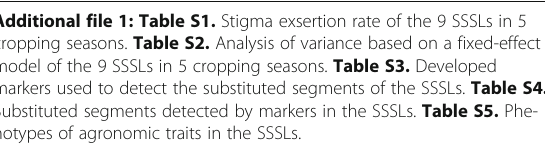
Additional file 1: Table S1. Stigma exsertion rate of the 9 SSSLs in 5 cropping seasons. Table S2. Analysis of variance based on a fixed-effect model of the 9 SSSLs in 5 cropping seasons. Table S3. Developed markers used to detect the substituted segments of the SSSLs. Table S4. Substituted segments detected by markers in the SSSLs. Table S5. Phe- notypes of agronomic traits in the